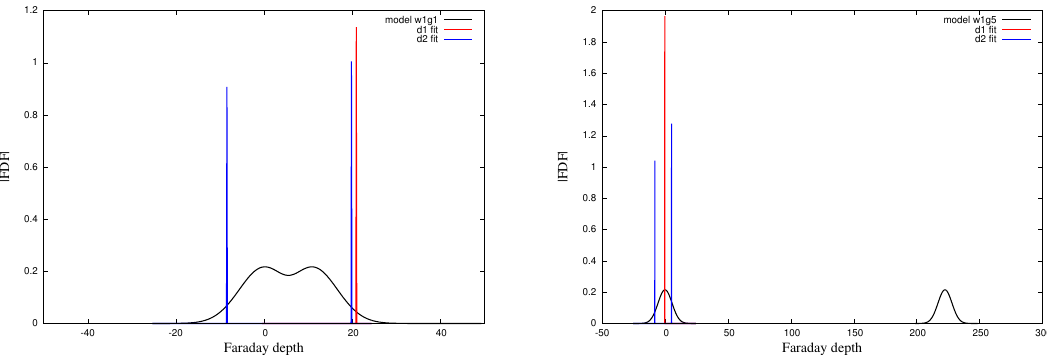
Figure 5. The reconstructed FDF by the Delta 1 (d1) (red) and d2 (blue) fitting models for the w1g1 (left) and w1g5 (right) source models, respectively. The black lines show the source model